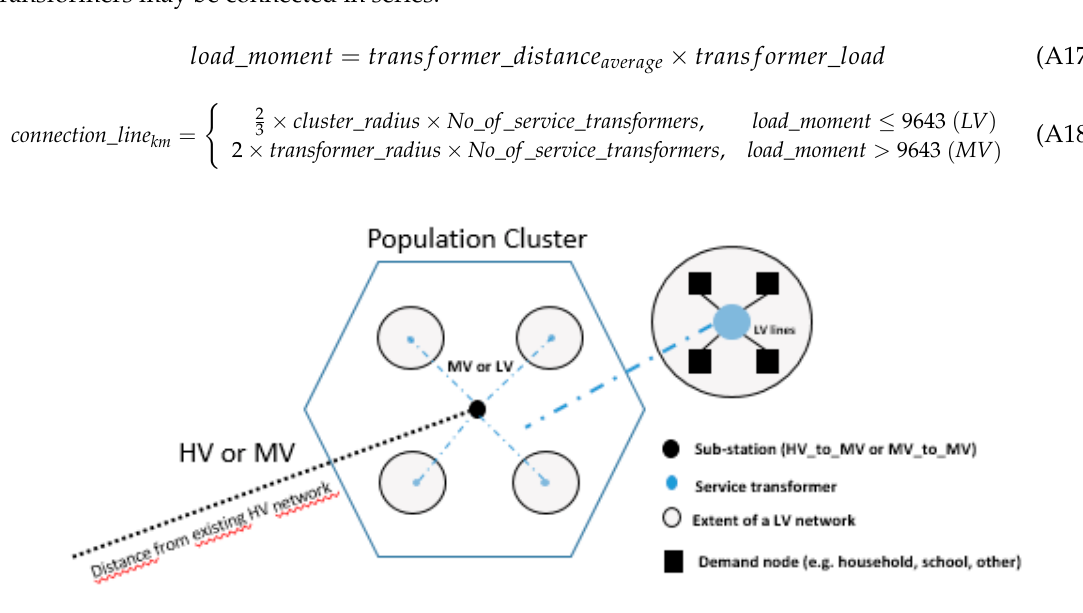
Figure A4. Estimating the size of transformers and their connection to sub-station.